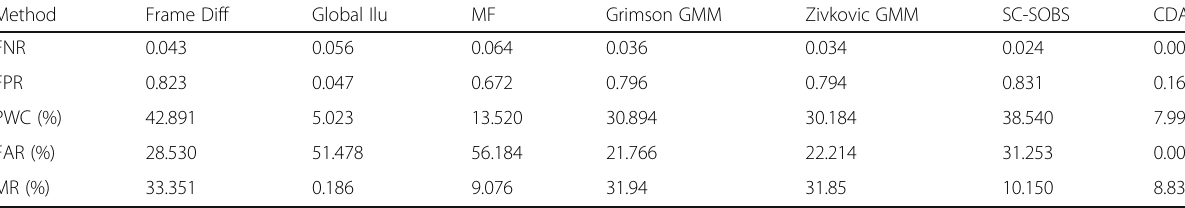
Table 3 Comparison results with the hand-labeled dataset in a noisy environment